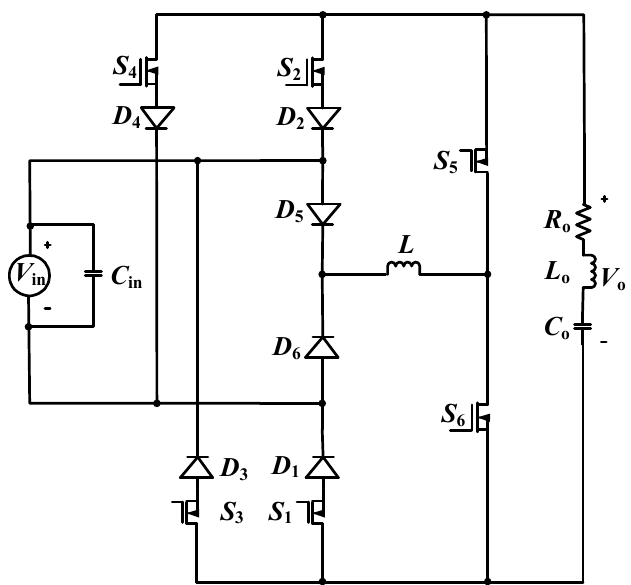
Figure 2. Direct frequency controller with reduced solid-state devices.